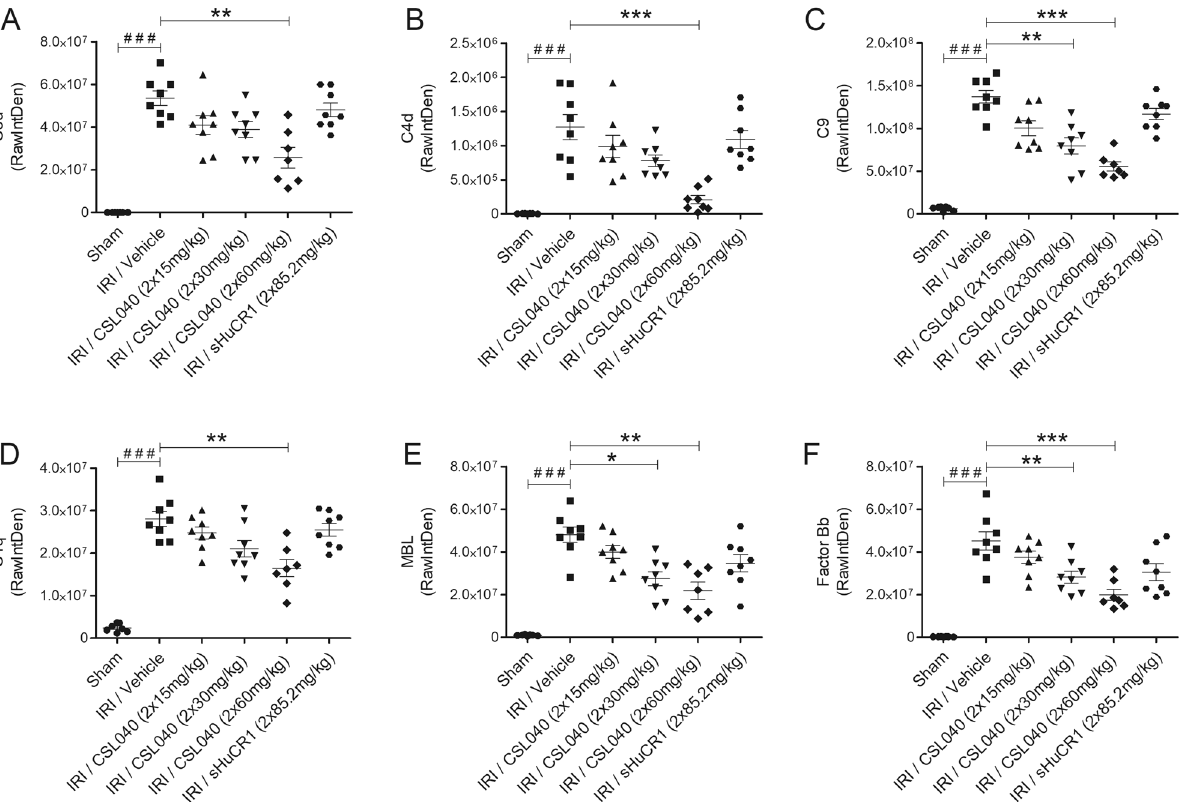
Figure 3. Reduction of IR-induced complement activation and tissue deposition by CSL040 treatment. Twenty-four hours after reperfusion, kidney sections were assessed for ( A ) C3d, ( B ) C4d, ( C ) C9, ( D ) C1q, ( E ) MBL, and ( F ) factor Bb deposition by immunofluorescence staining/confocal microscopy and image J analyses. Significance was tested using Mann–Whitney U test ( ### p < 0.001 for sham vs. IRI/vehicle), and One- way ANOVA Kruskal–Wallis and Dunn multiple comparisons test (*p < 0.05, **p < 0.01, ***p < 0.001). The data shown are mean ± SEM (n = 7–8 per group).